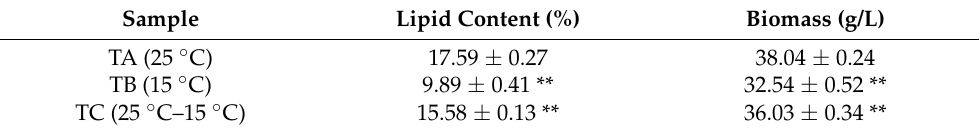
Table 1. Lipid contents and biomass in three groups (i.e., TA, TB, and TC) of Mortierella alpina under three different temperatures. The condition “25 ◦ C–15 ◦ C” indicates the temperature first at 25 ◦ C for 5 d and then at 15 ◦ C for 2 d. The symbol “**” indicates a significant difference set at a p -value of 0.01 in comparison to the TA